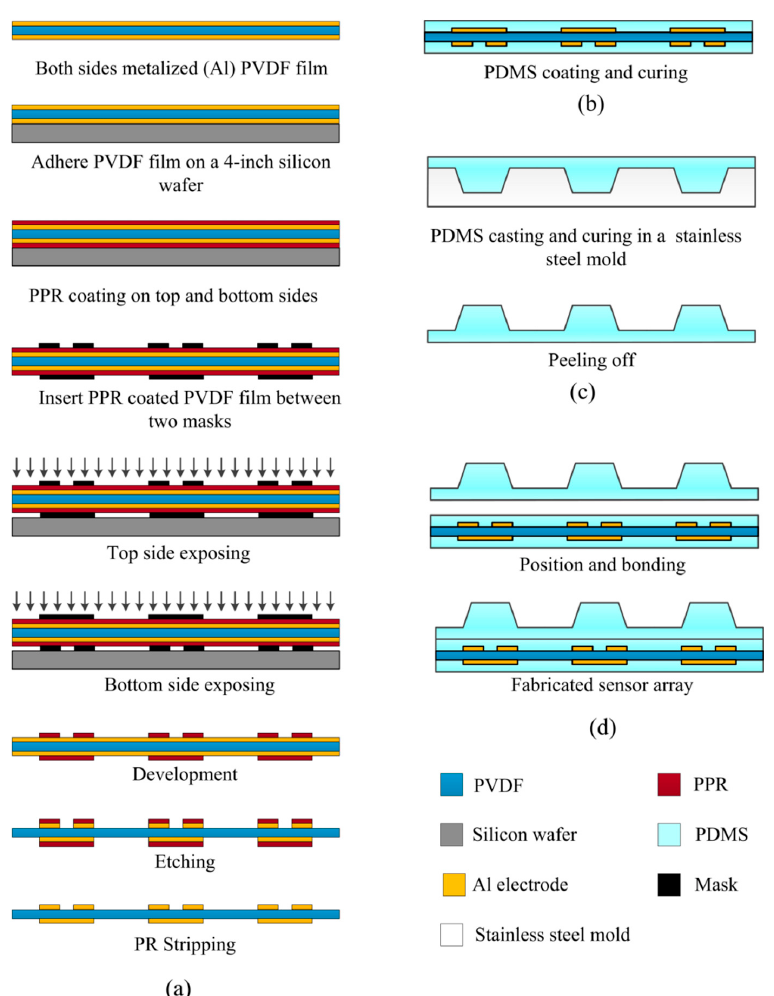
Figure 3. Fabrication process of the proposed three–axis tactile sensor array. ( a ) Electrode layers; ( b ) PDMS protecting layer; ( c ) PDMS bump layer; and ( d ) position and